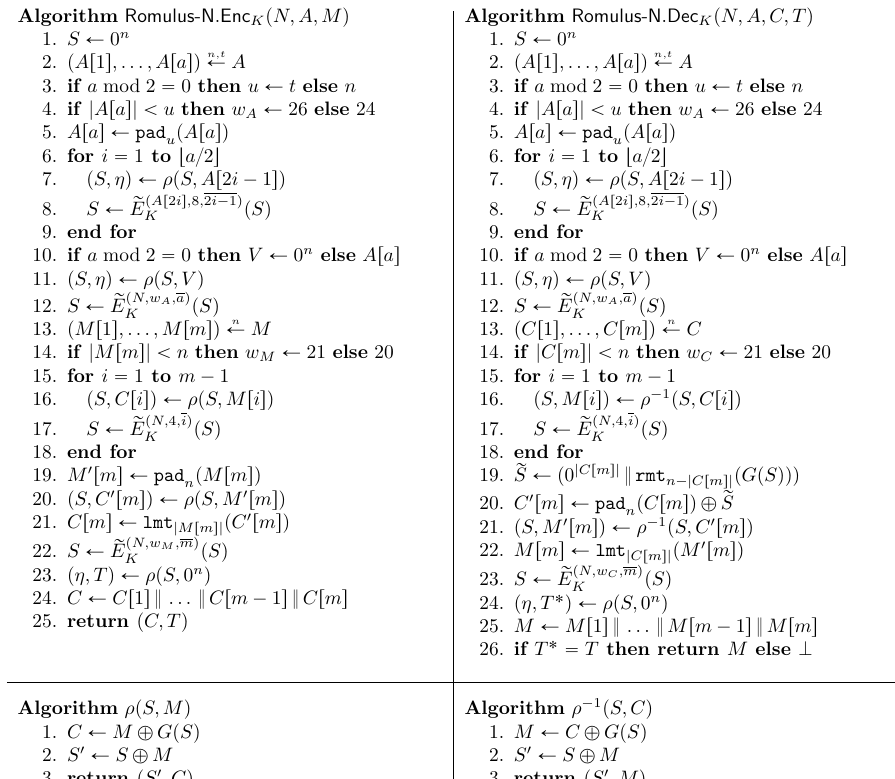
Figure 2: The Romulus-N nonce-based AE mode. Lines of [if (statement) then X Ð x else x 1 ] are shorthand for [if (statement) then X Ð x else X Ð x 1 ] . The dummy variable η is always discarded. We use Romulus - N 1 as working example. For other Romulus-N members, the values of the bits b 7 and b 6 in the domain separation (specified in Appendix B) need to be adapted